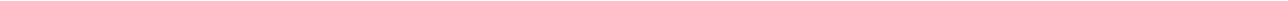
Figure 1 | Integrative analysis of gene expression and metabolic data sets identifies alterations in the hexosamine biosynthetic pathway in prostate cancer. ( a ) Overview of integrative methodology. ( b ) Top pathways identified after integrative analysis using combined gene/metabolite-derived enrichment scores using our previously published 10 data. Black dots indicate top six pathways identified as outliers and coloured arrows indicate the top five enriched pathways chosen for secondary analysis. ( c ) Network representation of pathways shown in b (solid coloured circles: enriched pathways after integrative analysis using combined gene/metabolite-derived enrichment scores; circumference is correlated to pathway connectivity). Association between interacting pathways and each of the enriched pathways (solid coloured circles) obtained after the integrative analysis is shown by coloured arrows, which also show the direction of interaction. Arrow thickness correlates with number of interacting components between two pathways. Enriched associated pathways (also termed interacting pathways) interacting with those listed in b , are shown in red rimmed circles. Thus, for example, amino sugar metabolism or HBP has eight interacting pathways, 5 of which are enriched (red rimmed circle). ( d ) Overview of the HBP. GNPNAT1 (red) is the most proximal consistently upregulated HBP enzyme in PCa. ( e ) GNPNAT1 product/substrate ratio was higher in PCa compared with matched benign-adjacent prostate tissues ( n ¼ 15 pairs). P -value was calculated using Unpaired Student’s t -test. ( f ) Boxplots showing immunostaining of GNPNAT1 in primary PCa ( n ¼ 67) versus benign adjacent (Ben, n ¼ 48), PCa versus lymph node mets (LN-Met, treatment naı¨ve, n ¼ 28) and PCa versus CRPC mets (Met, n ¼ 50). P -value was calculated using Wilcoxon-Rank Sum test. ( g ) Representative photomicrograph of GNPNAT1 staining in 1: Ben (black arrows) with tumour nodules (red arrow); 2: PCa; 3, 4: LN-Met and 5, 6: Mets. Representative scale bar for sections 1, 3 and 4 is 100 m m (low power) and for sections 2, 5 and 6 is 25 m m (high power). In all cases, P -value of o 0.05 was considered significant. For boxplots, the horizontal line represents median value, whereas Whiskers represent either o 25 or 4 75 quartile